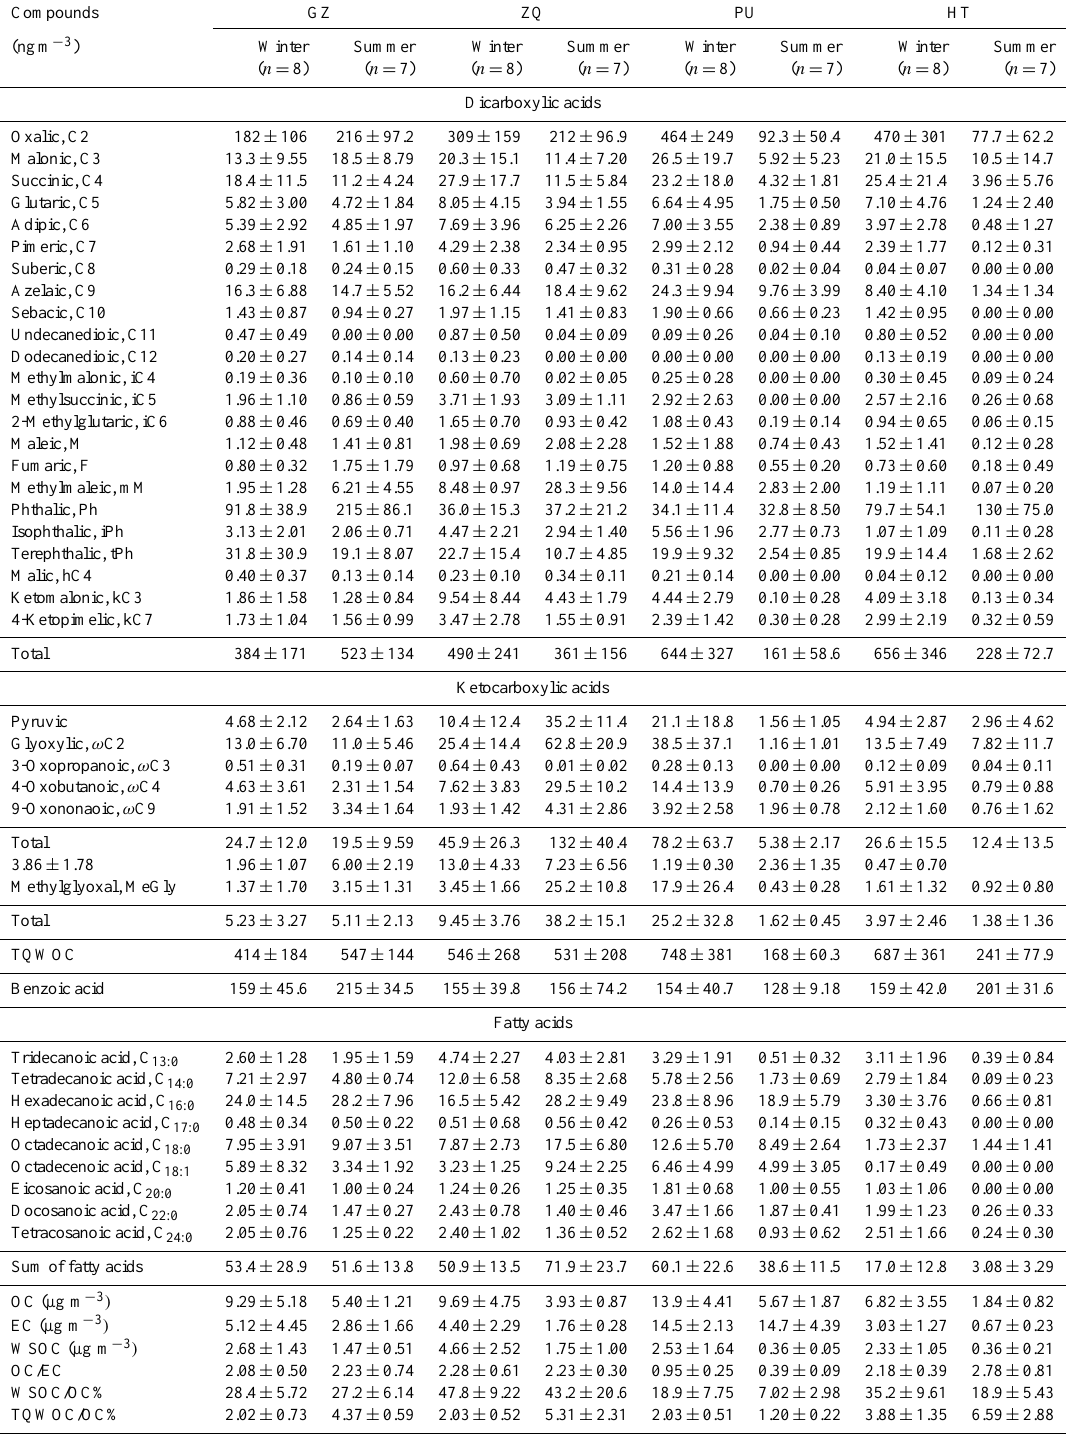
Table 1. Concentrations of dicarboxylic acids, ketocarboxylic acids, benzoic acid, and fatty acids in PM 2 . 5 samples in PRD during winter and summer in 2006–2007, Guangzhou (GZ), Zhaoqing (ZQ), The Hong Kong Polytechnic University (PU), Hok Tsui